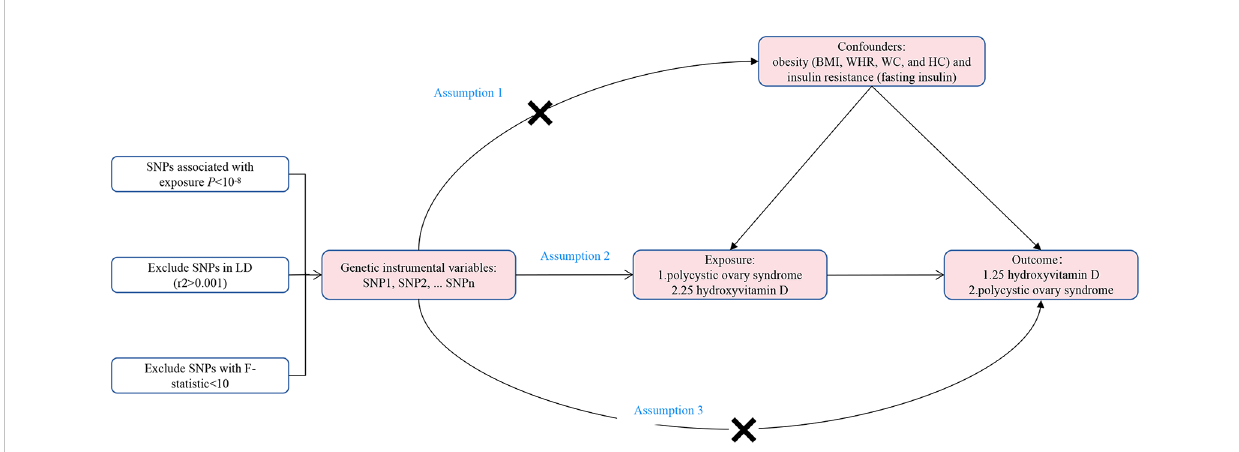
FIGURE 1 The framework of the bidirectional two-sample Mendelian randomization study between polycystic ovary syndrome and 25-hydroxyvitamin D. SNP, single nucleotide polymorphism; BMI, body mass index; WHR, waist-to-hip ratio; WC, waist circumference; HC, hip circumference; LD, linkage